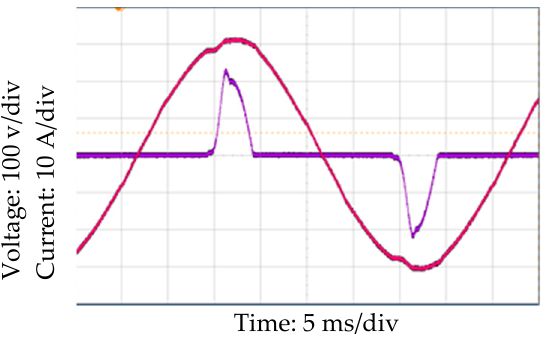
Figure 10. Experimental results of the output voltage and the load current. Table 3. Experimental data of the output voltage under resistive and rectifier loads.